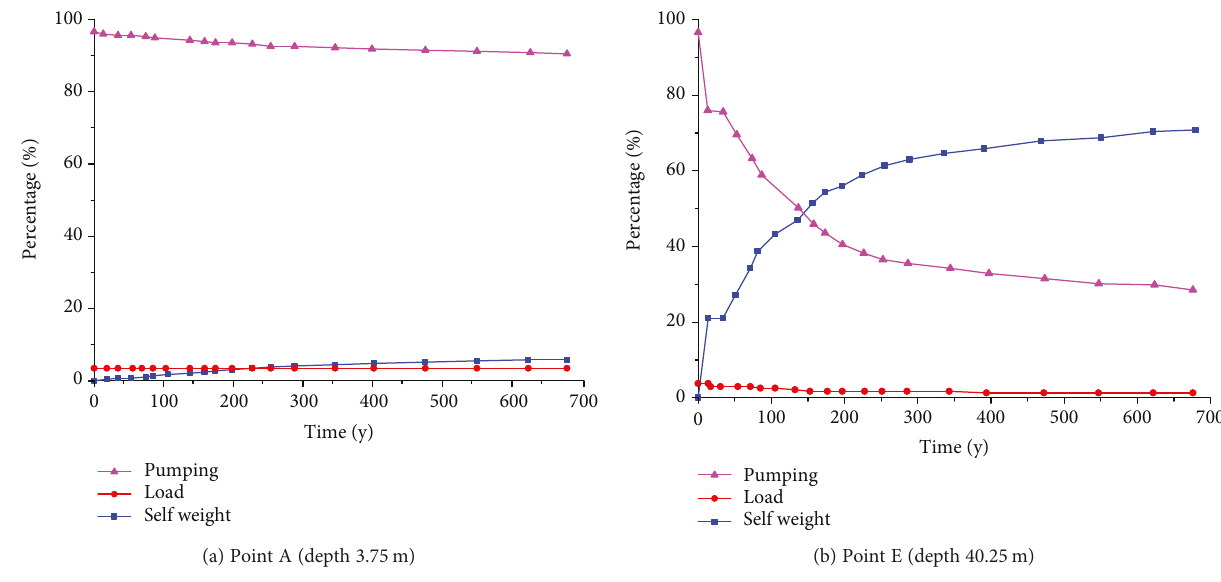
Figure 15: Percentage of partial settlement and total settlement at groundwater level